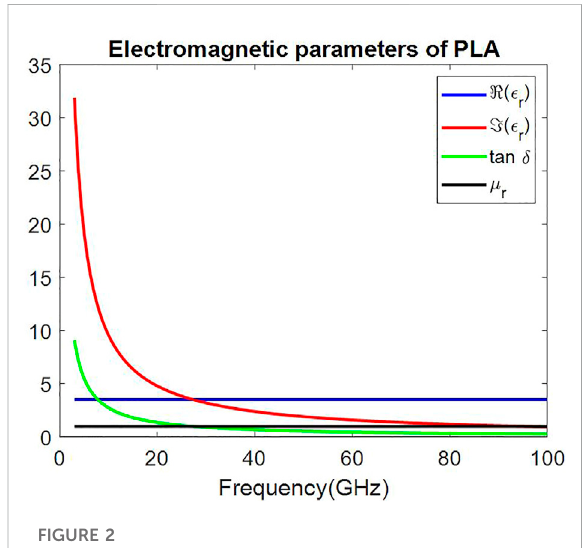
FIGURE 2 Electromagnetic parameters of PLA. Considered values are dielectric constant ε r = 3.5, conductivity σ = 5